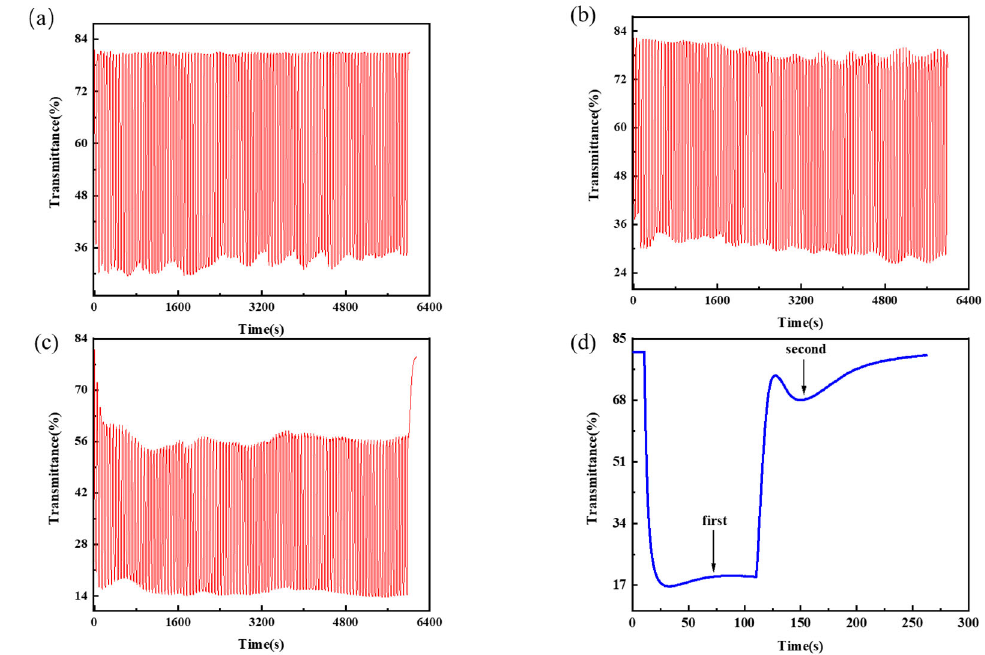
Figure 10. Time diagram of transmittance for 100 cycles of ammonium metatungstate concentration × iron (II) chloride concentration at a current density of 5 A/m 2 : ( a ) 0.175 mol/L × 0.30 mol/L, ( b ) 0.200 mol/L × 0.30 mol/L, and ( c ) 0.225 mol/L × 0.30 mol/L; ( d ) the transmittance time diagram for ammonium metatungstate concentration of 0.225 mol/L and iron (II) chloride concentration of